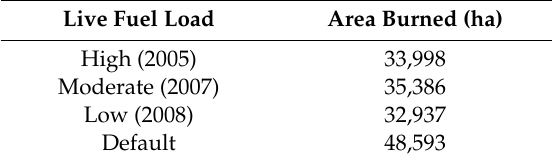
Table 2. Burned area simulated by Fire Area Simulator (FARSITE) for fuel loads in di ff erent